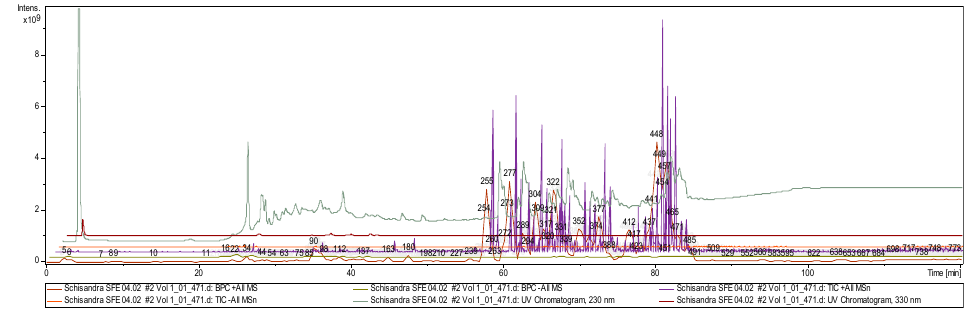
Figure 2. Chemical profiles of S. chinensis (Russia), ion chromatogram from SC-CO 2 extract.